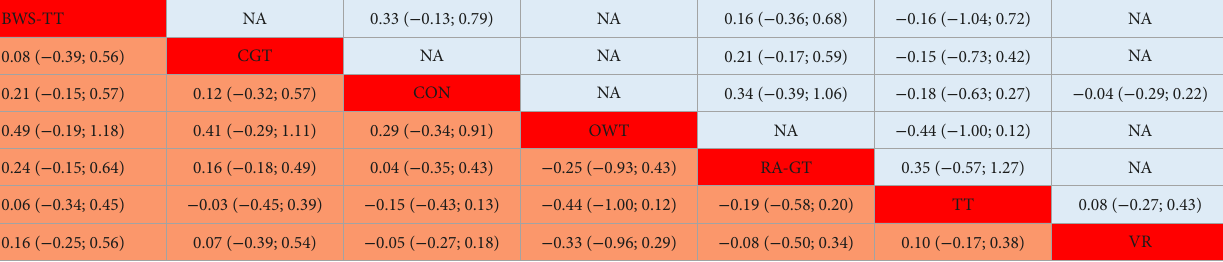
Blue means relative degree of direct comparison between gait training. Light red means relative degree of combined comparison between gait training. Deep red means gait training. TT, treadmill; BWS-TT, body-weight-supported treadmill training; RA-GT, robot-assisted gait training; VR, virtual reality gait training; CGT, conventional gait training; OWT, overground walking training; CON, control group.